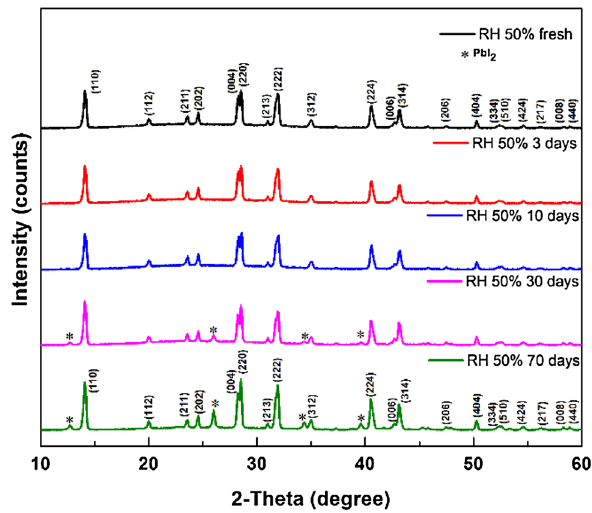
Fig. 2 XRD patterns of fresh perovskite film and stored at RH 50 % for 3, 10, 30, and 70 days. The PbI 2 phase is present in the film stored for 30 days and increases slowly after 70 days storage